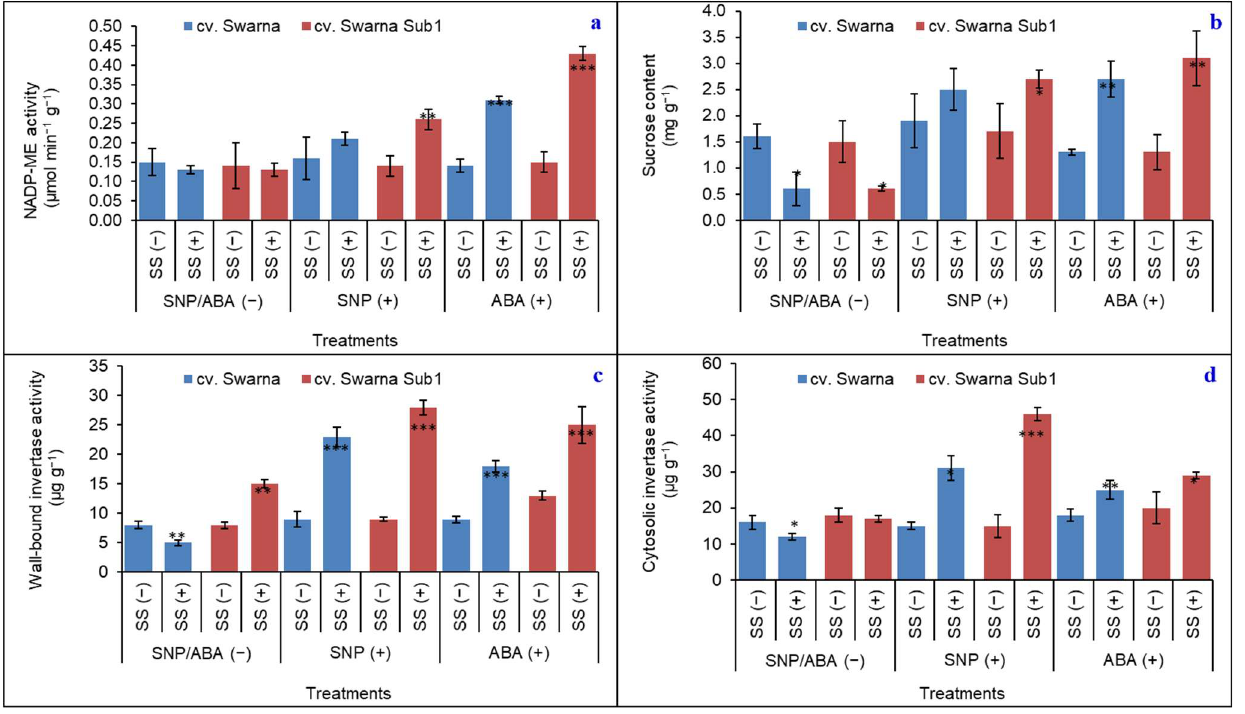
Figure 5. Changes in NADP-ME activity ( a ), sucrose content ( b ), wall-bound invertase activity ( c ) and cytosolic invertase activity ( d ) in two rice genotypes (cv. Swarna and Swarna Sub1) under salinity stress [SS (+)] and non-salinity stress [SS ( − )] for 72 h with [SNP (+) or ABA (+)] or without [SNP/ABA (−)] priming for 24 h. Data are presented in bars with mean ± SE ( n = 3) from independent experimental sets and the significant values are represented as * ( p ≤ 0.05), ** ( p ≤ 0.01) and *** ( p ≤ 0.001) by student’s t -test to denote the significant difference between SS (−) and SS (+) of SNP/ABA (−) as well as SNP (+) and ABA (+) of each rice genotype.